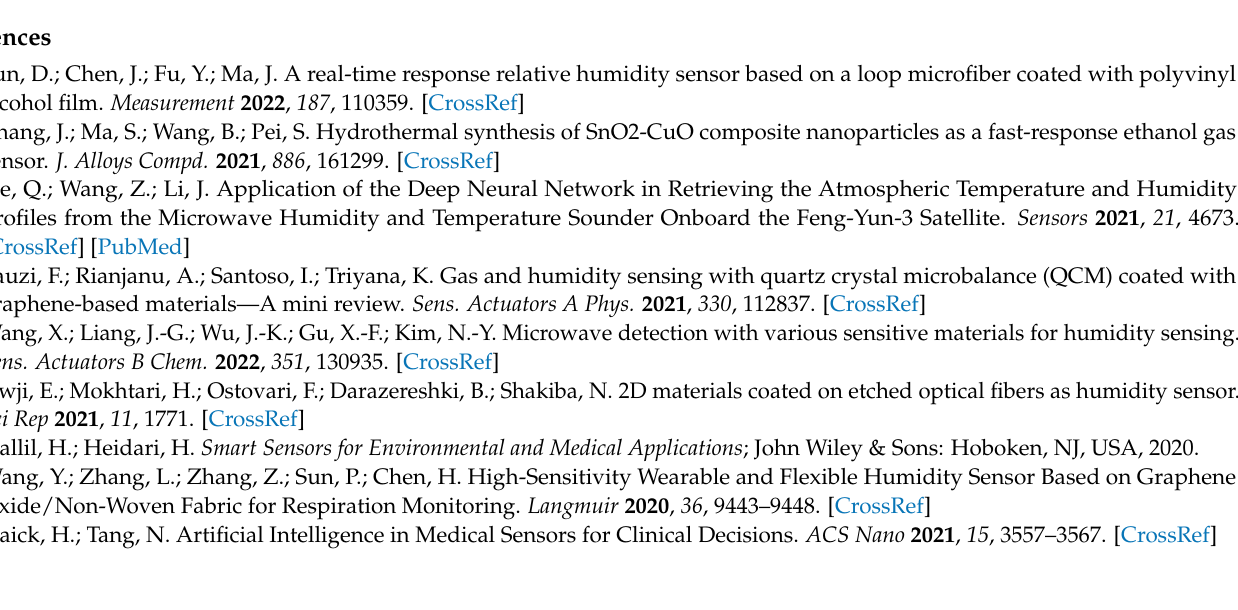
contact angle measurements. Figure S2. Sensor response extraction algorithm. Figure S3. Laboratory experimental setups. Figure S4. Outdoor experimental setup. Figure S5. Sensor magnitude response to RH in range 0–90%. Figure S6. Sensor long-term stability and response and recovery time extracted from magnitude response. Figure S7. Sensor magnitude response to temperature. Figure